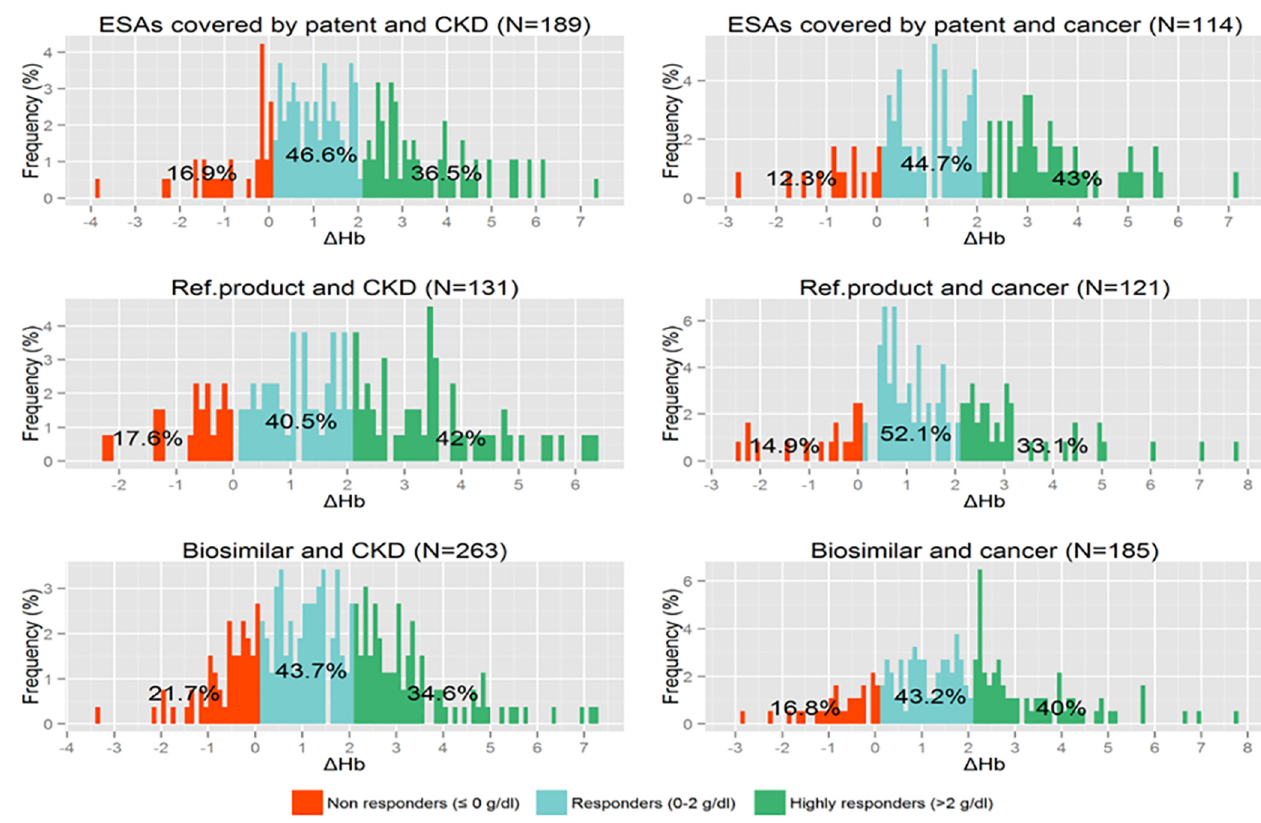
Fig 5. Responsiveness to ESA treatment, assessed as delta Hb ( Δ Hb) between follow-up and baseline Hb value, stratified by indication for use and type of ESA. Hb = hemoglobin; CKD = Chronic kidney disease; ESAs = Erythropoiesis-stimulating agents; Ref. Product = Reference